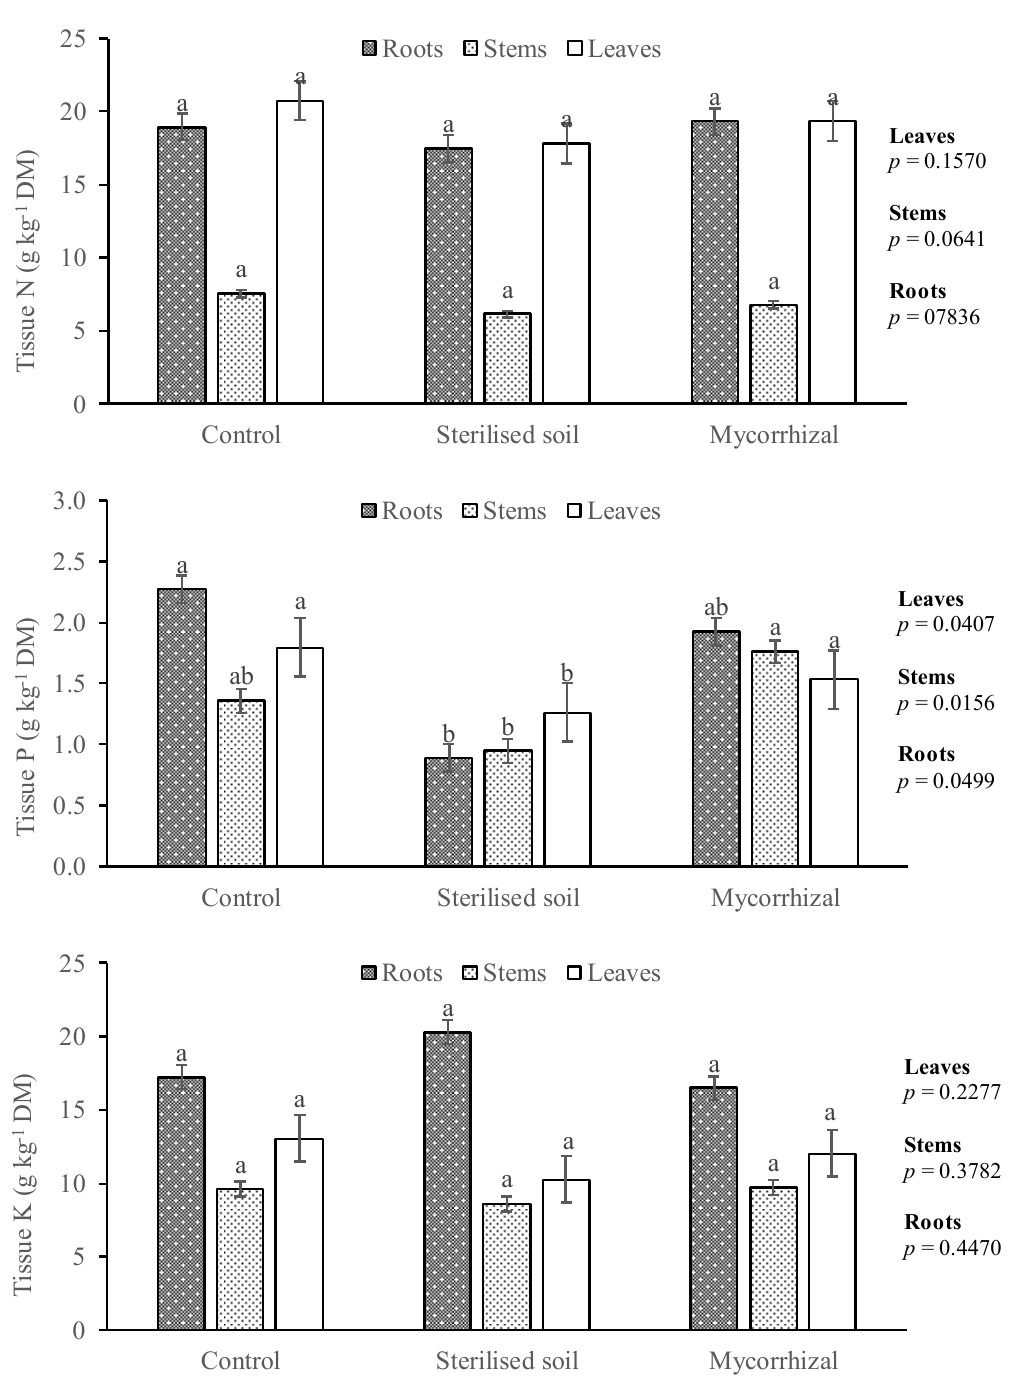
Figure 4. Tissue nutrient concentration as a function of soil treatments. After ANOVA examination ( p , Prob. > F), within each plant part, means ( n = 6) followed by the same letter are not significantly different by Tukey HSD test ( α = 0.05). Vertical bars are the standard errors.